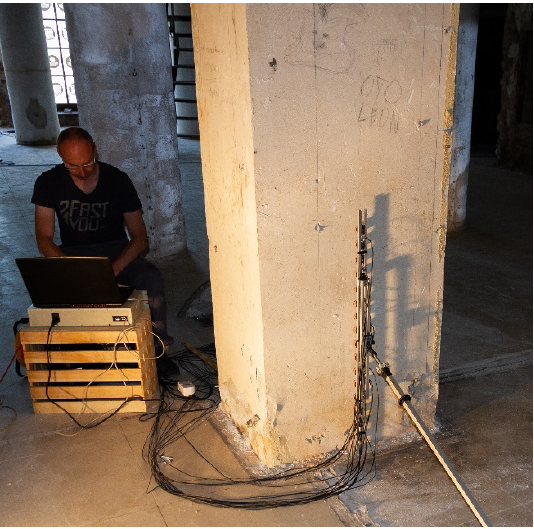
Figure 3. The building of the Heimann’s Foundation in Wrocław: internal pillar with EIT electrodes on opposite sides.